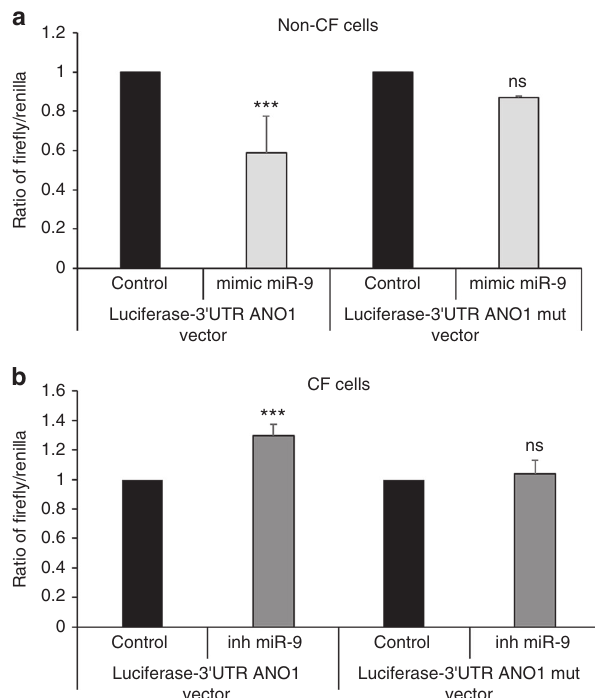
Fig. 3 miR-9 directly targets ANO1 3 ′ UTR in non-CF and CF cells. a Relative luciferase activity in non-CF cells (16HBE14o-) transiently transfected with a luciferase-3 ′ UTR ANO1 vector or a luciferase-3 ′ UTR ANO1 vector mutated at miR-9-binding sites and co-transfected with a miR-9 mimic or a negative control (control). Fire fl y luciferase activity was normalized to Renilla luciferase activity ( n = 3, with 8 replicates). Histograms represent average values ± SDs and were compared using Student ’ s t -test. b Relative luciferase activity in CF cells (CFBE41o-) transiently transfected with luciferase-3 ′ UTR ANO1 or luciferase-3 ′ UTR ANO1 mutated at miR-9- binding sites and cotransfected with an inhibitor of miR-9 (inh miR-9) or a negative control (control). Fire fl y luciferase activity was normalized to Renilla luciferase activity ( n = 3, with 8 replicates). Histograms represent average values ± SDs and were compared using Student ’ s t increase (Supplementary Fig. 12a, b). We concluded that miR-9 directly regulates ANO1 in CF cells.